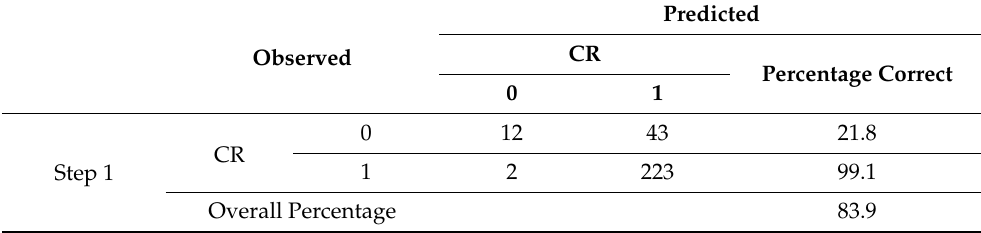
Table 3. Classification